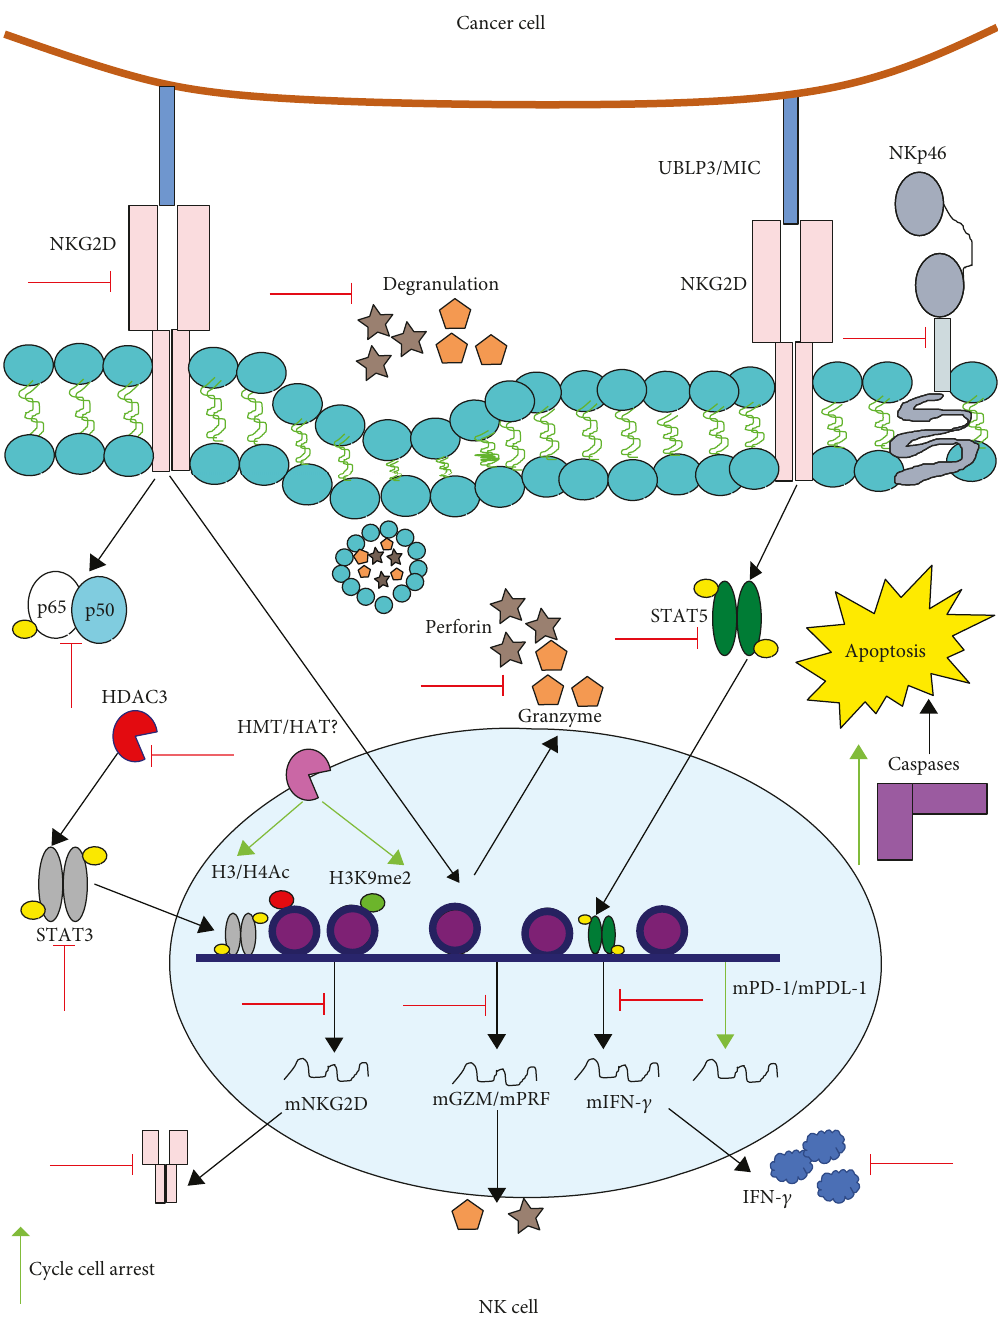
Figure 7: VPA reduces the cytolytic activity in NK lymphocytes against tumor cells. VPA reduces the expression of certain receptors that participate in the identi fi cation of tumor cells, including NKp46, NKp30 (not shown), and NKG2D. This last system of receptors recognizes overexpressed stress molecules (UBLP3/MIC) in malignant cells, which leads to the activation of di ff erent lytic-related activation pathways in the NK cell. It is feasible that VPA a ff ects these pathways, including IFN- γ secretion by reducing STAT5 phosphorylation, as well as the production of both granzyme B and perforin, which are intimately linked to cellular degranulation. VPA also diminishes NF- κ B activation and the expression of NKG2D, by promoting the acetylation and methylation of the H3 histone that is next to the locus of this gene, and it blocks HDAC3, which strongly impacts STAT3 phosphorylation, which is required for the expression of this receptor. Furthermore, VPA blocks the cell cycle progression and increases the expression of both PD1 and the death ligand PD-L1, which is correlated with an increase in caspase expression and therefore with apoptosis. Green arrows indicate the processes, molecules, or mediators in the signaling pathway that are augmented and/or promoted by VPA. Red arrows indicate processes, molecules, or mediators in the signaling pathway that are inhibited by